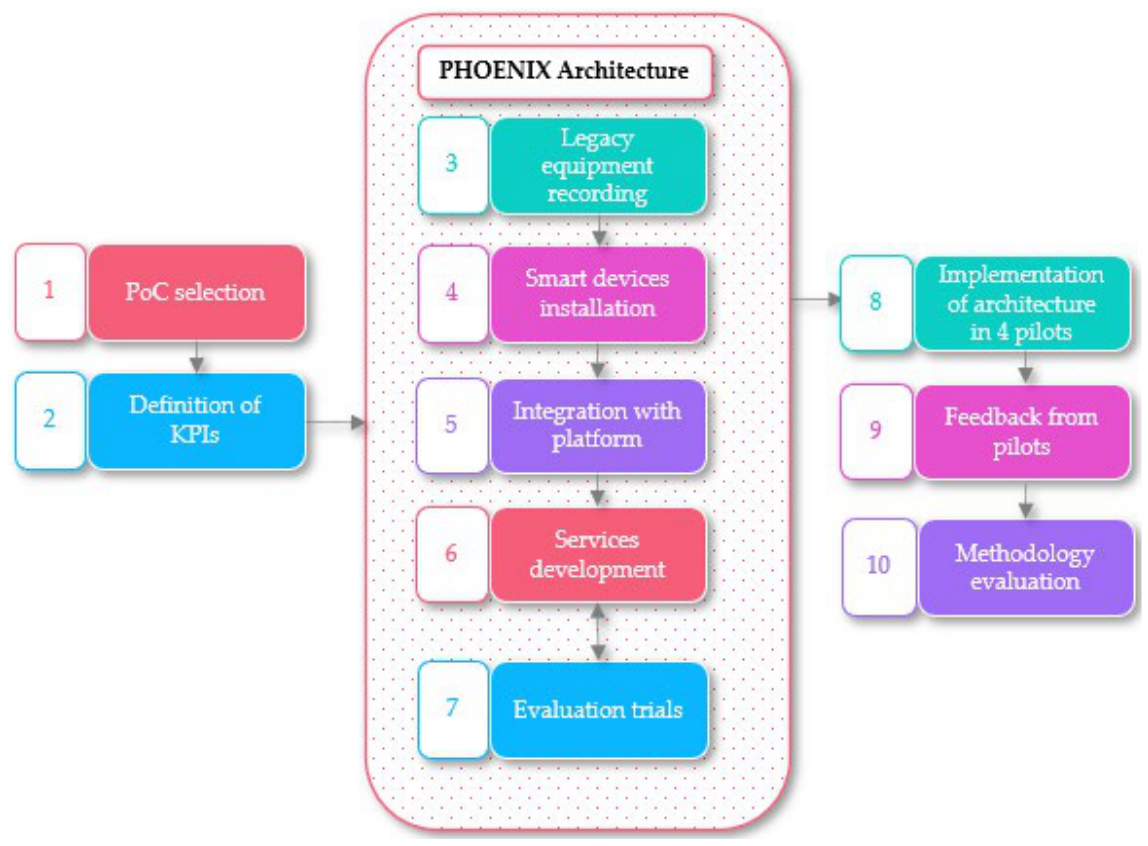
Figure 1. PHOENIX 10-step integration methodology .